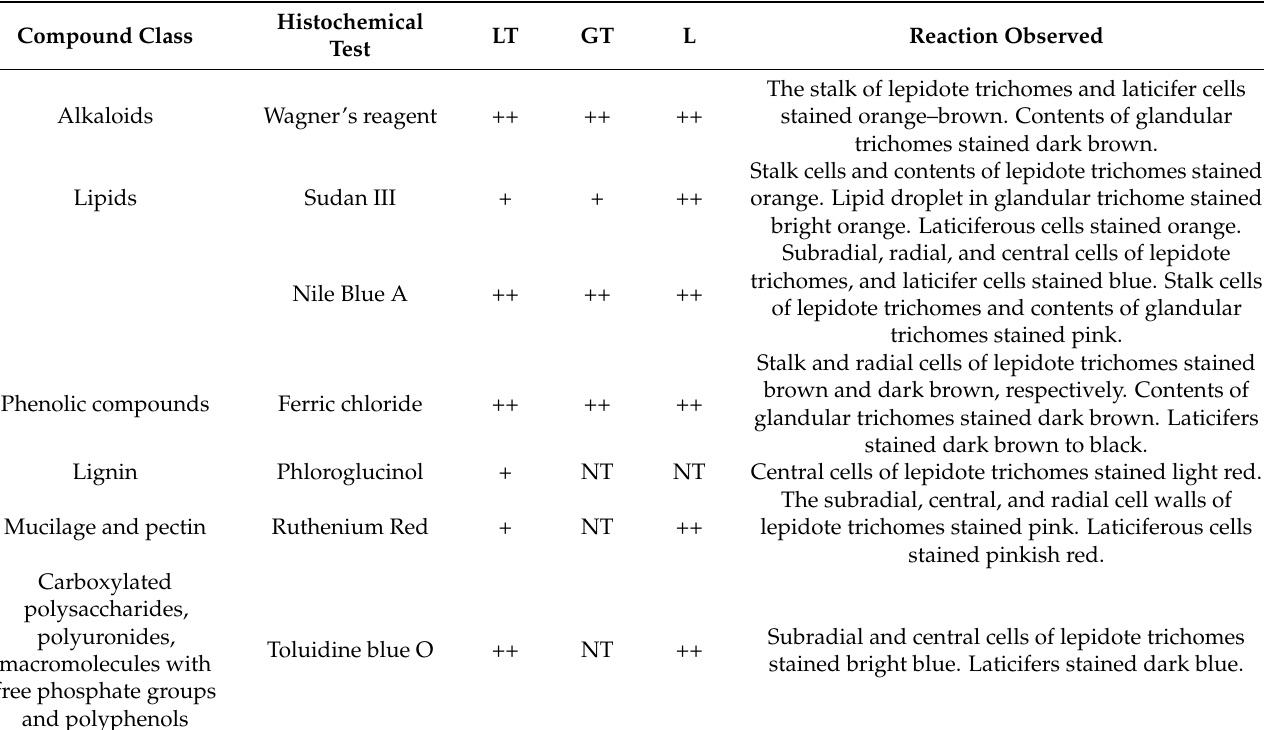
Table 1. Histochemical analysis of lepidote trichomes (LT), glandular trichomes (GT), and laticifers (L) of C. gratissimus var. gratissimus